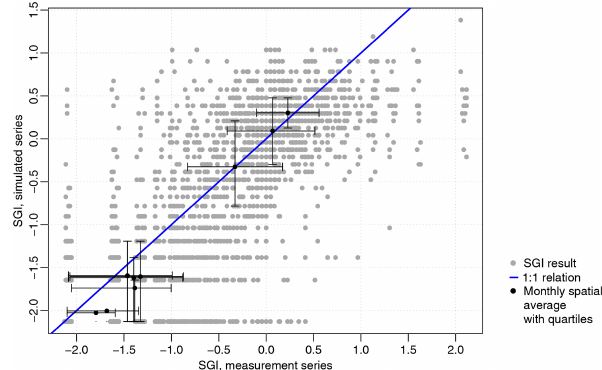
Figure 8. Comparison of SGI values over April–December 2018 based on cleaned long measurement series ( x axis) and based on simulated series ( y axis) for all location–month combinations (grey dots). Black dots show the average over all locations for each month, with quartiles (spatial